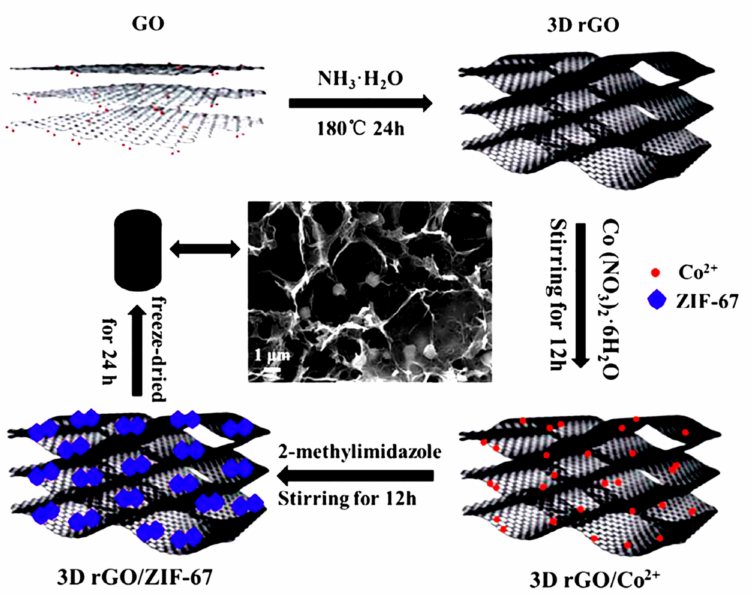
Figure 17. Synthesis of the 3D ZIF-67-rGO composite aerogel. Reprinted with permission from [331]. The synthesized composite shows the maximum adsorption capacities up to 1714.2 mg/g and 426.3 mg/g for CV and MO, respectively. In particular, loading ZIF-67 on 3D rGO aerogel increases the adsorption capacity of 3D ZIF-67-rGO aerogel to MO. Accordingly, the adsorption capacities towards MO are 119.2 mg/g, 403.3 mg/g, and 417.1 mg/g for the 3D rGO aerogel, ZIF-67 matrix, and 3D ZIF-67-rGO aerogel, respectively. Analogous adsorption improvement was observed for the removal of CV